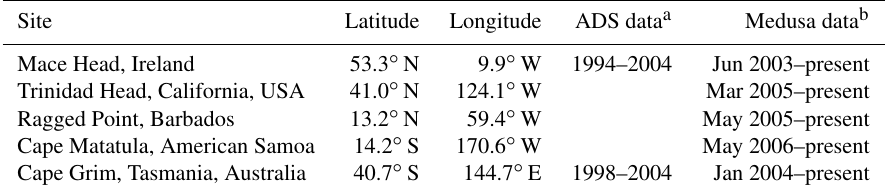
Table 2. Overview of the core AGAGE sites used in this study, their coordinates and periods for which data are